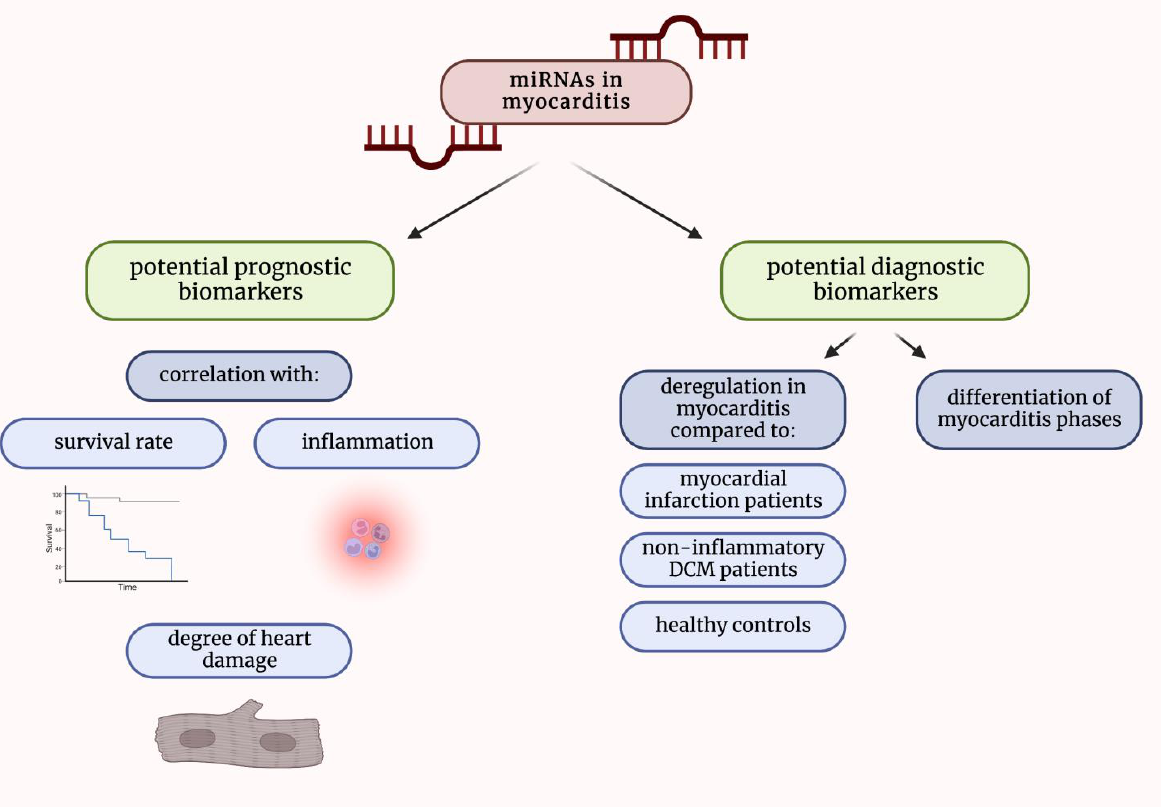
Figure 3. Graphical summarization of the role of miRNAs as potential diagnostic and prognostic biomarkers in myocarditis. DCM — dilated cardiomyopathy; miRNAs — micro-ribonucleic